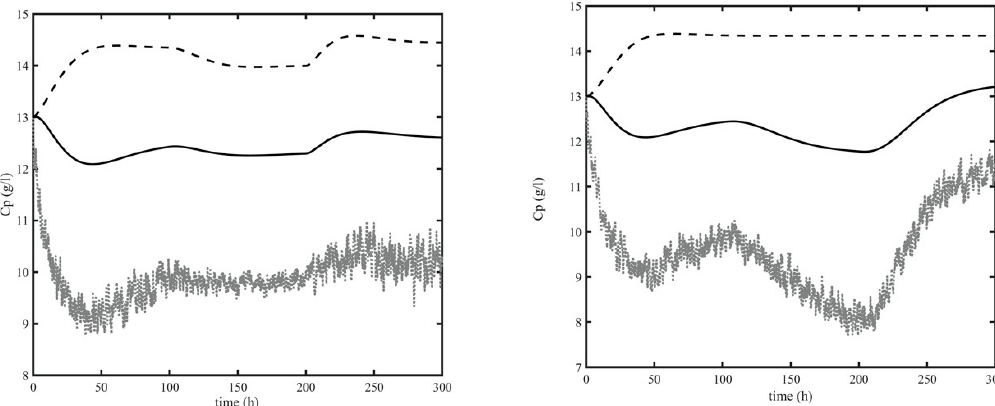
Figure 2. Dynamic response of ethanol concentration calculated with the virtual plant (continuous line), open-loop model (dashed line) and GO (dotted grey line) for structure φ 1 along trajectory T1 ( left panel) and T2 ( right panel).